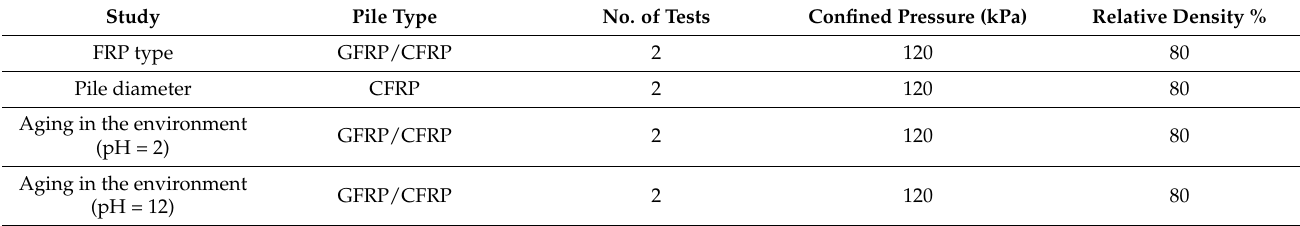
Table 3. Program for the lateral flexural stiffness